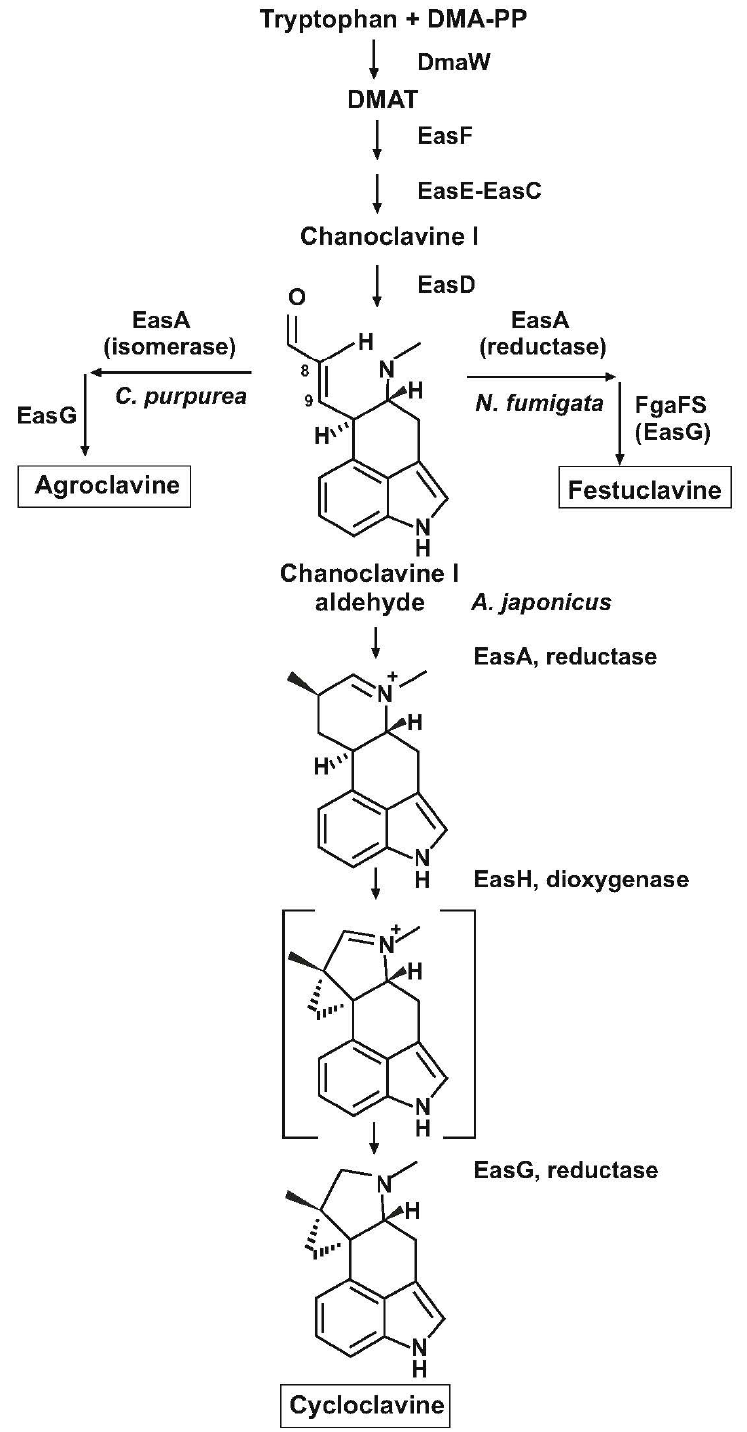
Figure 4. Biosynthetic pathway of cycloclavine in A. japonicus . The intermediate compound in brackets has been proposed by Jakubczyk et al. [7,8]. On each side the branches leading to agroclavine and festuclavine in C. purpurea and N. fumigata , respectively, are shown.